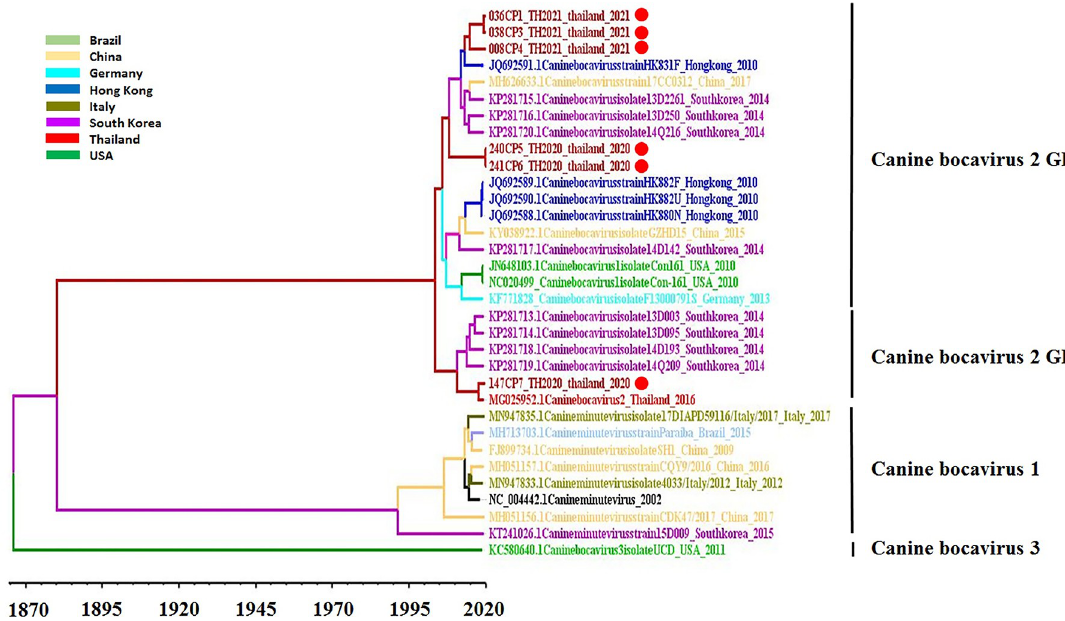
Fig 1. Maximum clade credibility tree of complete genome sequences of CBoV. A GTR model with a strict clock model. A coalescent Bayesian skyline tree prior run for 500 million chains. The tree branches are colored according to the sites where the strains were isolated. The red circles represent the CBoV strain collected in this